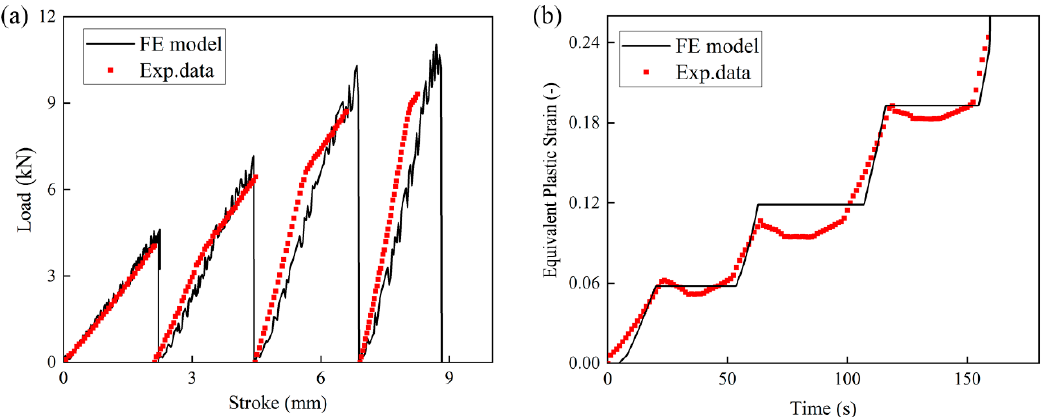
Figure 12. Comparison of cyclic plane strain loading and FE simulation: ( a ) Load-Stroke comparison; ( b ) EPS comparison at the central surface deformation area.